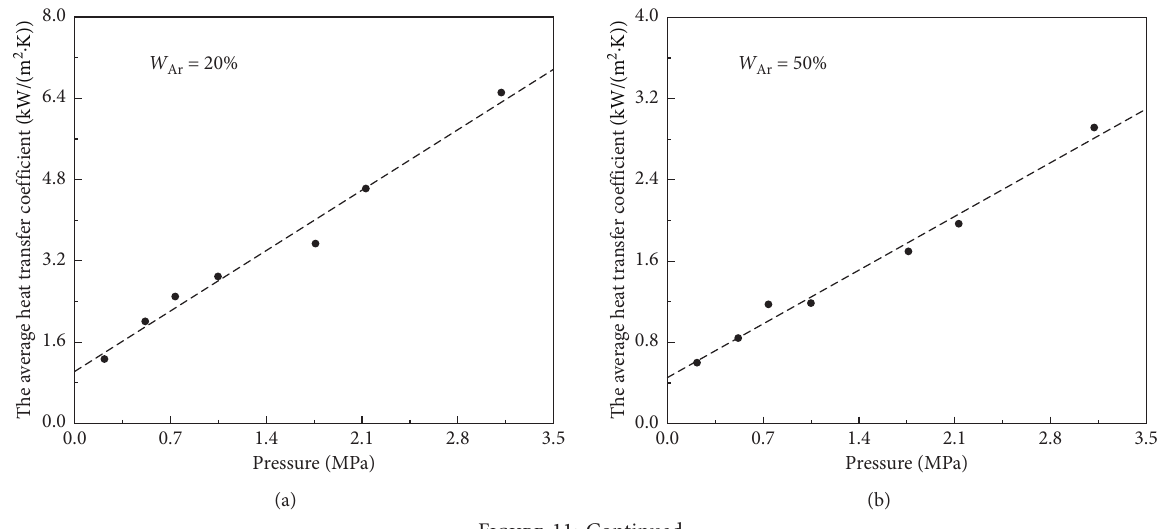
� 20%. (b) W � 50%. (c) W � 70%. (d) W � 2 . (a) W N2 N2 N2 N2